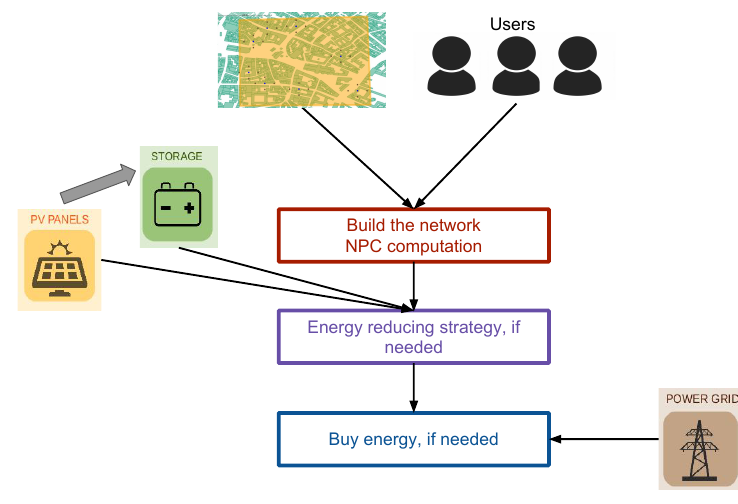
Figure 4. Flowchart of the research